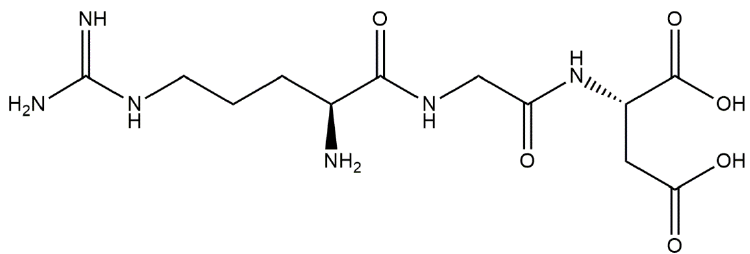
Figure 6. Schematic representation of vancomycin’s chemical